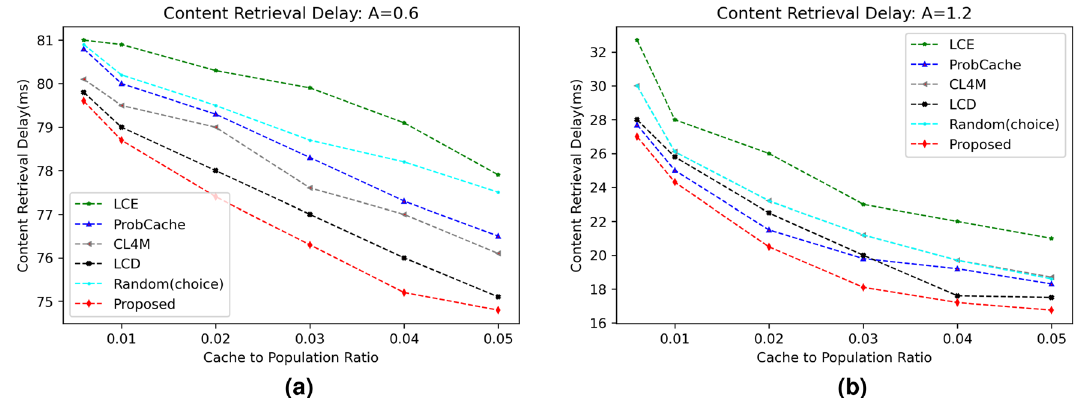
Figure 4. Influence of cache size on